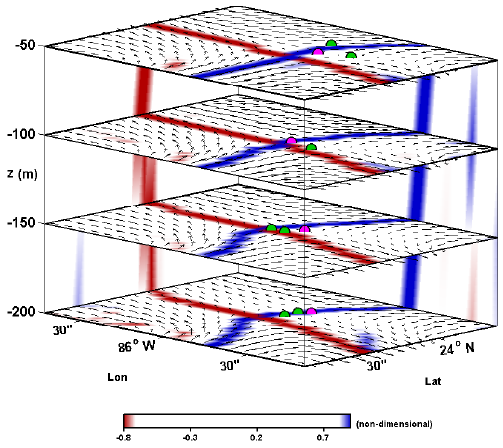
Fig. 2. FTLEs computed from 10 day trajectories and scaled by the maximum value within each layer, stagnations points (magenta bul- lets), nearby temperature saddle points (green bullets), and velocity field for 10 June 2010 at depths 50, 100, 150, and 200m. The blue and red curves denote the stable and unstable ridges of the FTLEs, respectively, derived from forwards, respectively backwards, in time